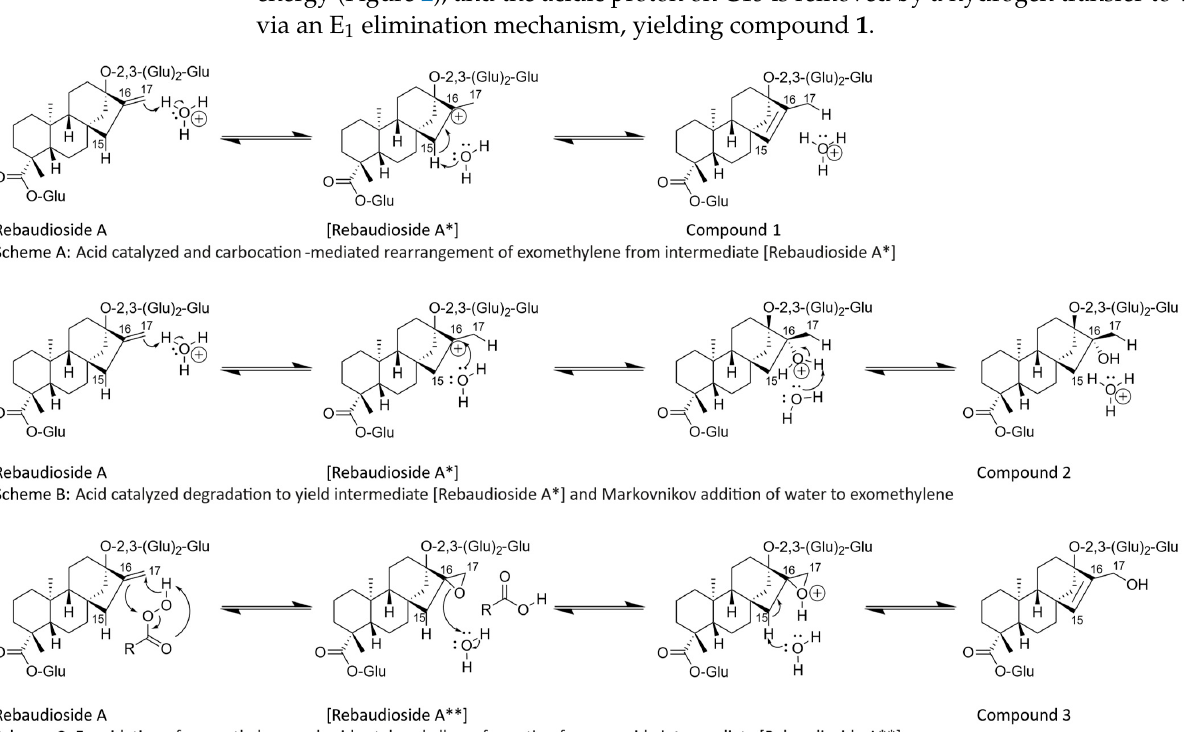
Figure 2. Potential energy diagram of Reb A and degradation compounds 1 – 3 .